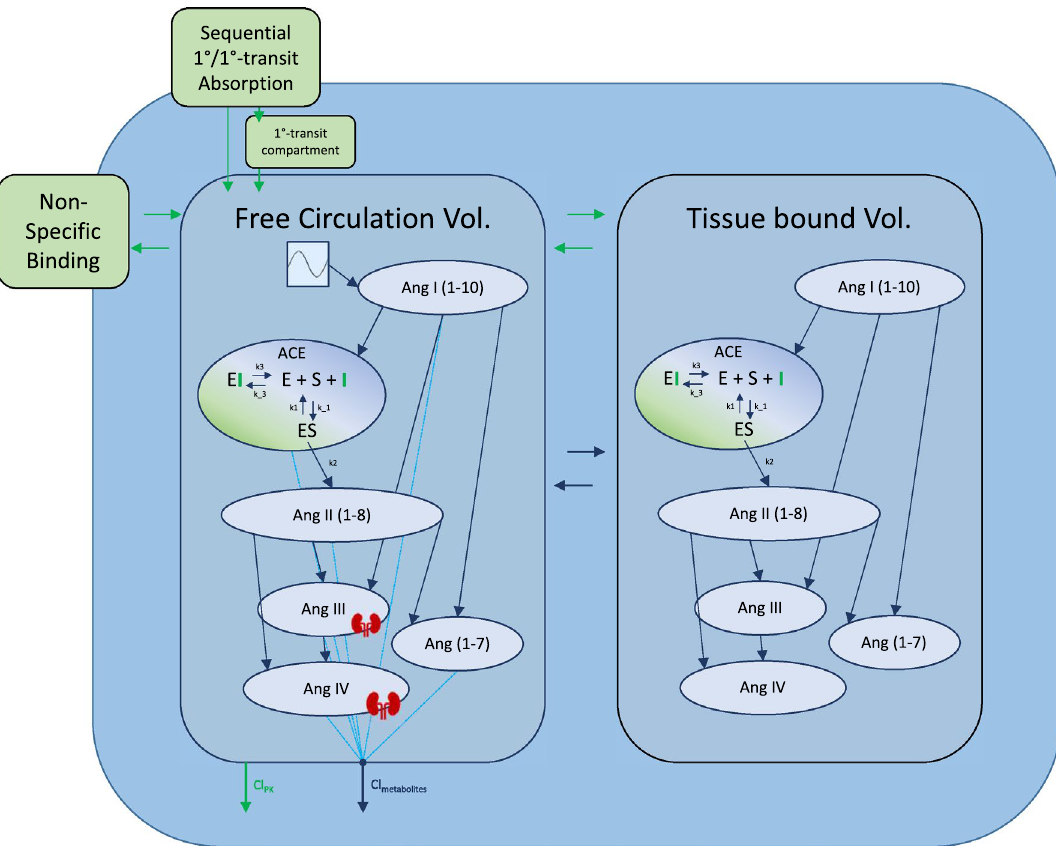
Figure 3. Detailed model diagram. Detailed diagram of the final model structure. Benazeprilat pharmacokinetics were modeled using a 2-compartment model with a mix of 1-order and 1-order delayed by 1-order transfer absorption from the depot compartment. Both volumes of distribution, free and tissue , were modeled with a fixed amount of ACE with which Benazeprilat could act on. Non-specific binding affected the free circulation compartment. A series of direct response models were used to describe the transformation of angiotensin I into its various metabolites . The free volume of distribution was subdivided into plasma and kidney volumes for Ang III and Ang IV. A Michaelis–Menten kinetic model of inhibitor, substrate, and enzyme interaction was used to describe the competitive inhibition of ACE by benazeprilat. k 3 and k -3 were the parameters governing ACE-benazeprilat (enzyme-inhibitor) association and dissociation, while k 1 and k -1 determined the rate of ACE-angiotensin (enzyme–substrate) association and dissociation. k 2 controlled the production rate of angiotensin II from angiotensin I via ACE. An independent clearance for each metabolite as well as benazeprilat controlled the rate of removal of various molecules from the